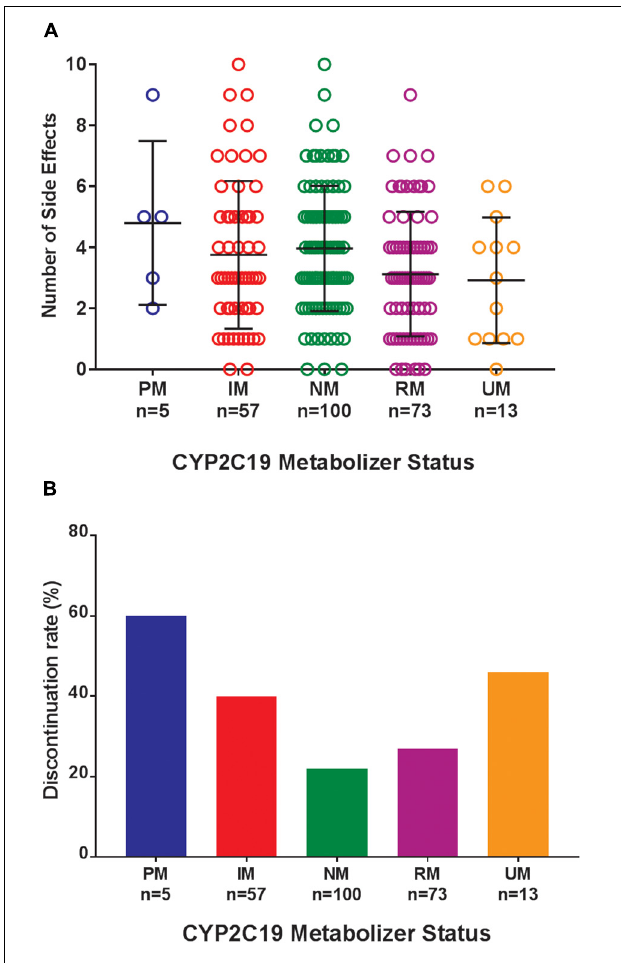
FIGURE 1 | (A) Total number of side effects experienced during treatment with escitalopram or citalopram (es/citalopram) by 248 patients included in the tolerability analysis. CYP2C19 metabolizer status is associated with the total number of side effects experienced ( p = 0.015). The association with CYP2C19 metabolizer status remained significant ( p = 0.019) in a multivariate regression model that accounted for es/citalopram dose and concomitant medications. Mean and standard deviation are indicated by the bar and whiskers. (B) Discontinuation rates by CYP2C19 metabolizer status in the tolerability analysis with a documented reason for discontinuation of es/citalopram in the electronic medical record. PMs and IMs were significantly more likely to discontinue es/citalopram relative to NMs ( p = 0.007, χ 2 ), while RMs and UMs were not ( p = 0.20, χ 2 ). PM, poor metabolizer; IM,